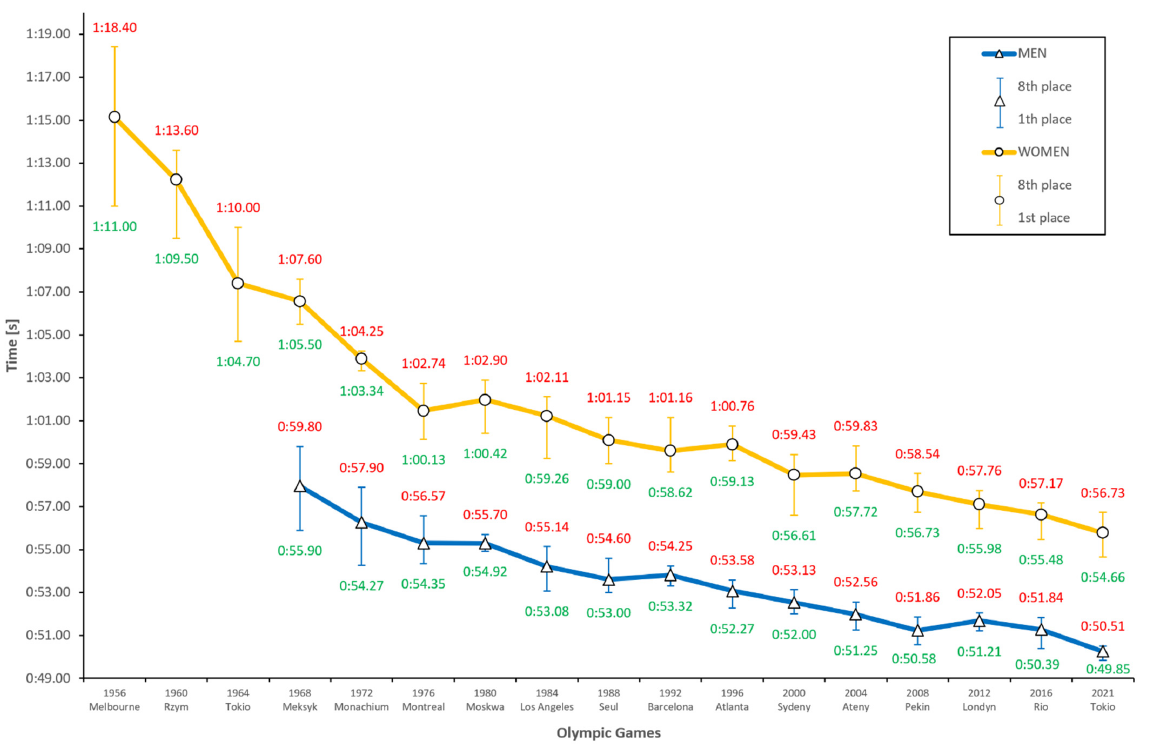
Figure 3. Men’s and women’s 100 m butterfly results during the last 16 Olympic Games and prediction for Tokyo 2021. Predictions for the Tokyo Olympics in 2021 reveal a clear progression. Average times